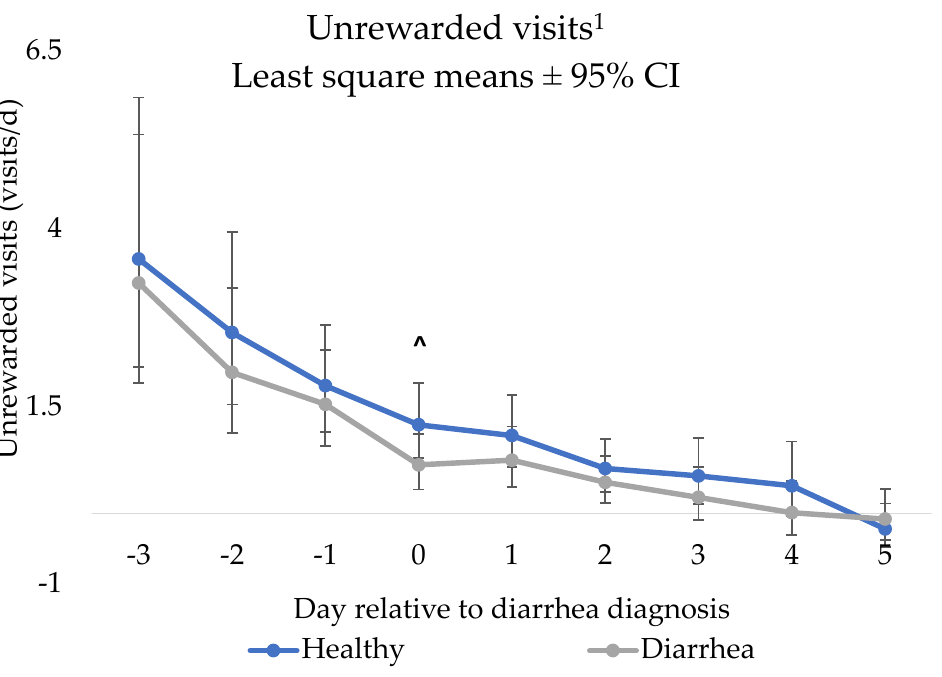
Figure 4. Results of the repeated measures mixed linear regression model assessing the relationship between day relative to neonatal calf diarrhea diagnosis (day 0) and least square mean unrewarded visits (visits/d) 1 of pair matched control ( n = 31) and diarrhea ( n = 31) calves fed by an automated milk feeder, preweaning. A calf was defined as having NCD if they had a fecal consistency score of 2 or 3 (runny to watery consistency) for two or more consecutive days. Calves were matched on farm, gender and age and the model included calf and pair number to account for the matched pair analysis. 1 Unrewarded visits were non-normally distributed, significant differences ( p ≤ 0.05) were obtained by transformation with common log and a correction factor. The least square means and error bars represent ± 95% confidence interval of the back transformed predicted values. ˆ indicates a tendency (> 0.05 p < 0.10). Table 3. Diagnostic abilities of all feeding behaviors which were significantly associated with neonatal calf diarrhea (NCD) status on the day of diagnosis (day 0) for control ( n = 31) and NCD pair matched preweaned calves ( n = 31) fed by an automated milk feeder. Cases of NCD were defined as having a fecal consistency score of 2 or 3 (runny to watery consistency) for two or more consecutive days. Cases calves were matched to control calves based on farm, sex, and age. Sensitivity was defined as the probability that a truly diseased calf was identified as diseased using its feeding behaviors collected from the automated milk feeder whereas specificity was defined as the probability that a truly healthy calf was identified as being healthy using feeding behaviors from the automated milk feeder.